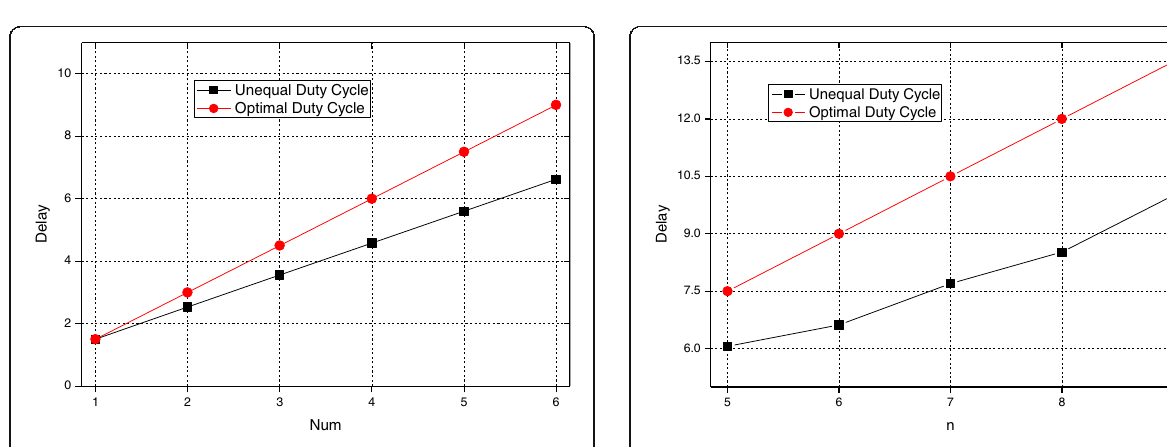
Fig. 25 The delay of UDCNP and ODCNP (MPSK)